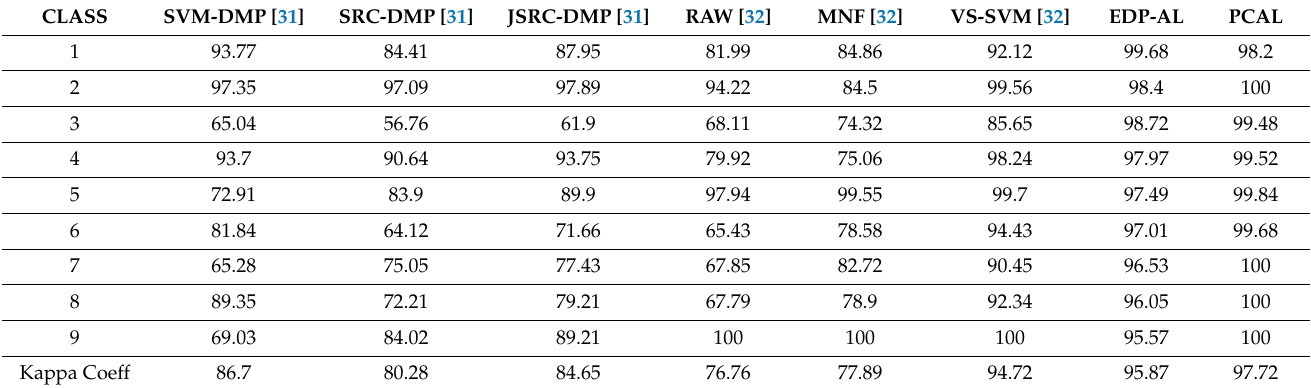
Table 5. Accuracy and Kappa Coefficient Analysis (Pavia